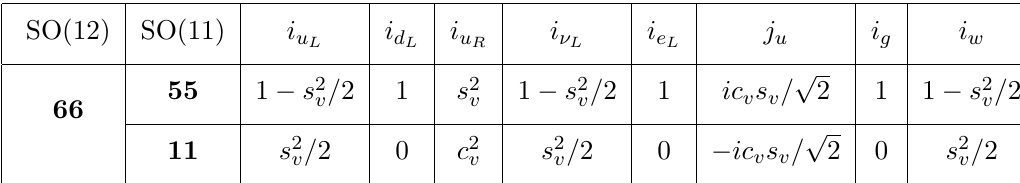
Table 2 . Invariants i r and j r of the kinetic and mass terms, in the background of the Higgs vev, f f with no vev for (cid:22) S 1 . We have used s v = sin v=f and c v = cos v=f . We only show the invariants of the (cid:12)elds that have a non-negligible degree of